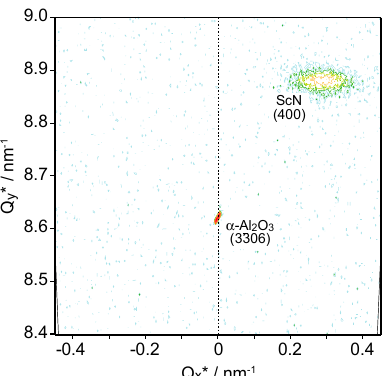
Figure 2. Reciprocal space mapping for the (3306) diffraction of the α -Al 2 O 3 (1102) substrate and the (400) diffraction of the ScN film. The directions of Q x * and Q y * indicate the 1101 direction of the α -Al 2 O 3 (1102) substrate and the film growth direction, respectively. The reciprocal lattice point of α -Al 2 O 3 (3306) is fixed at Q x * = 0.